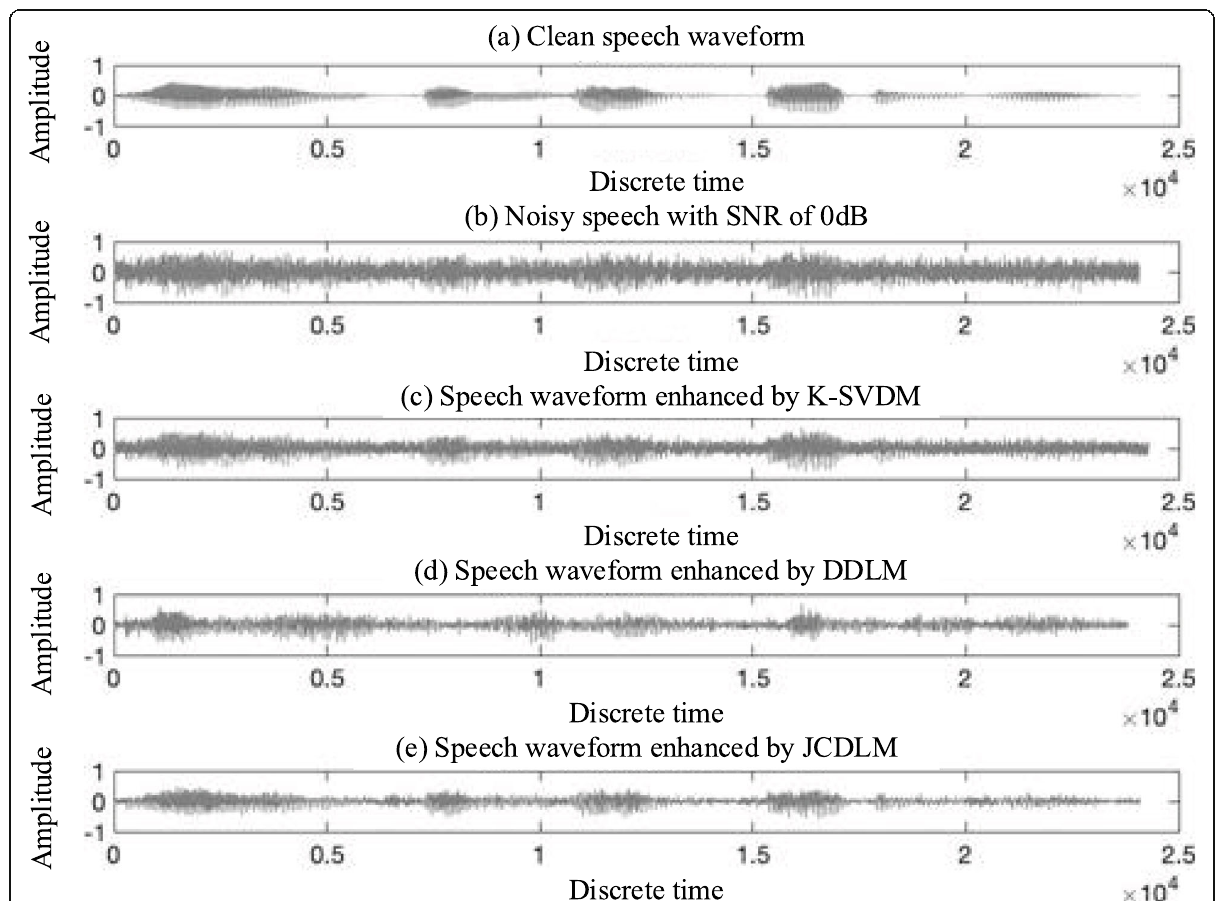
Fig. 8 Enhanced waveforms of different algorithms under 0-dB white